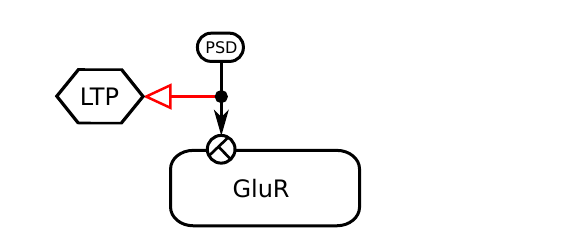
Figure 2.21: The Entity Relationship glyph for stimulation .